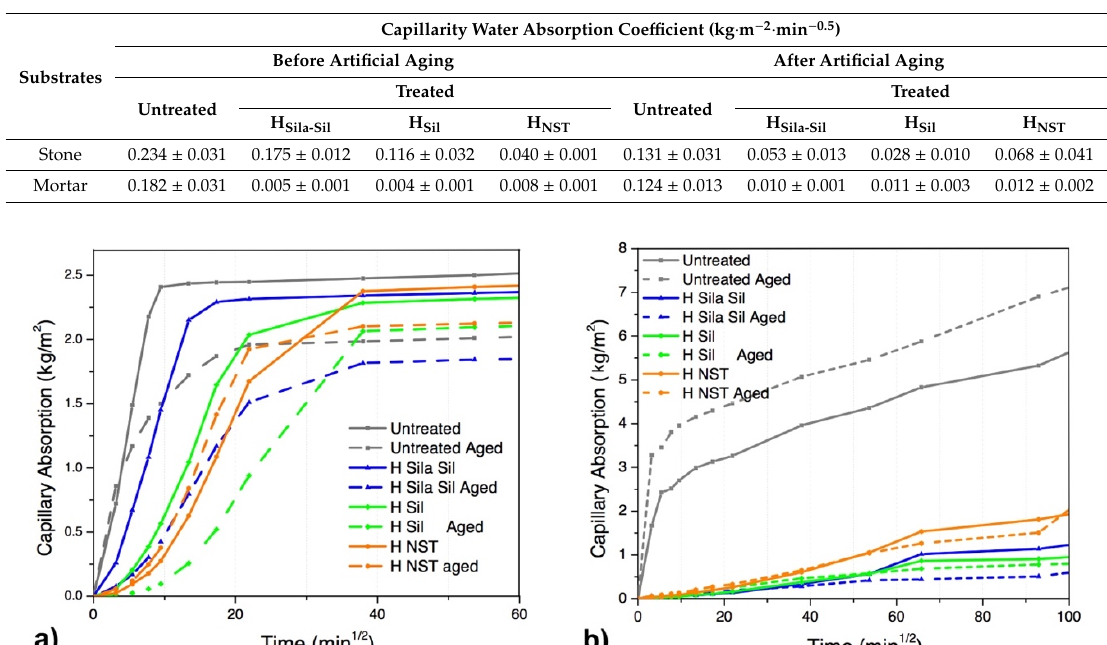
Table 4. Average results and relative standard deviation of the capillarity water absorption coe ffi cient (C) of treated and untreated specimens, before and after artificial aging tests.